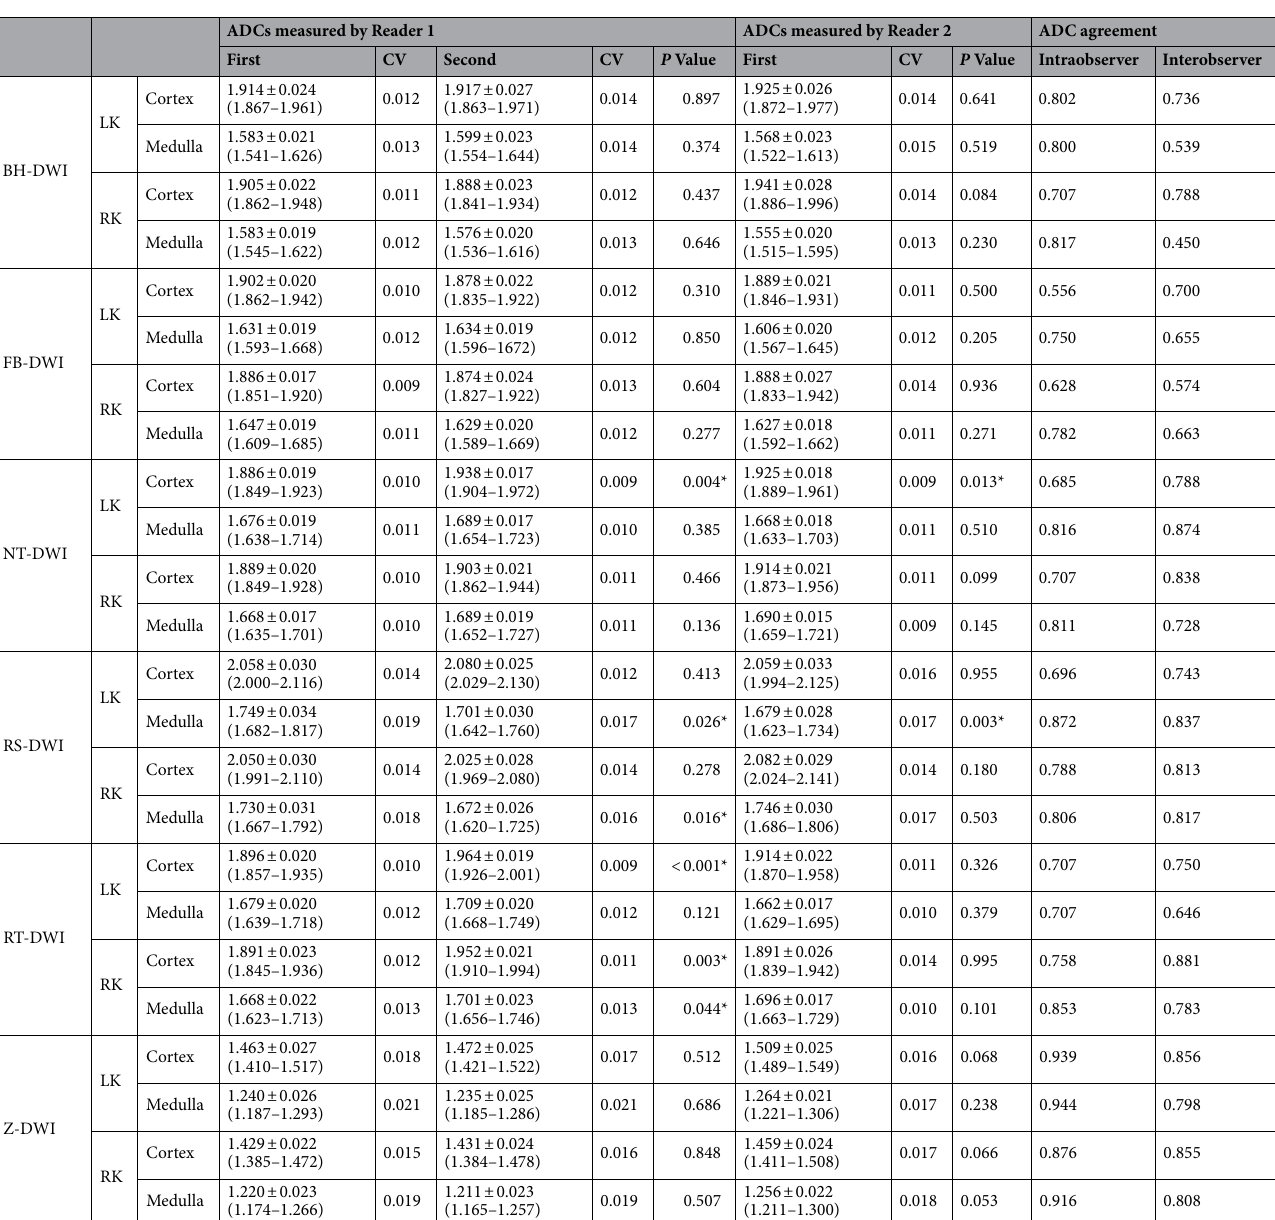
Table 1. The ADC measurement in six DWI techniques and their Intra- and Interobserver agreement between them. ADC are given in *10 −3 mm 2 /s. Mean ADC values measured in different anatomical regions. Data in parentheses are 95% confidence intervals. P values were gained by using the paired t test to compare differences for reader1 between the first and second ADC measurement, and to compare for the first ADC measurement between reader1 and reader2. P < 0.05 were considered significant difference (*). LK left kidney, RK right kidney, CV coefficient of variation, BH-DWI breath-hold DWI, FB-DWI free-breathing DWI, NT-DWI navigator-triggered DWI, RS-DWI readout-segmented DWI, RT-DWI respiratory-triggered DWI and Z-DWI Zoomit